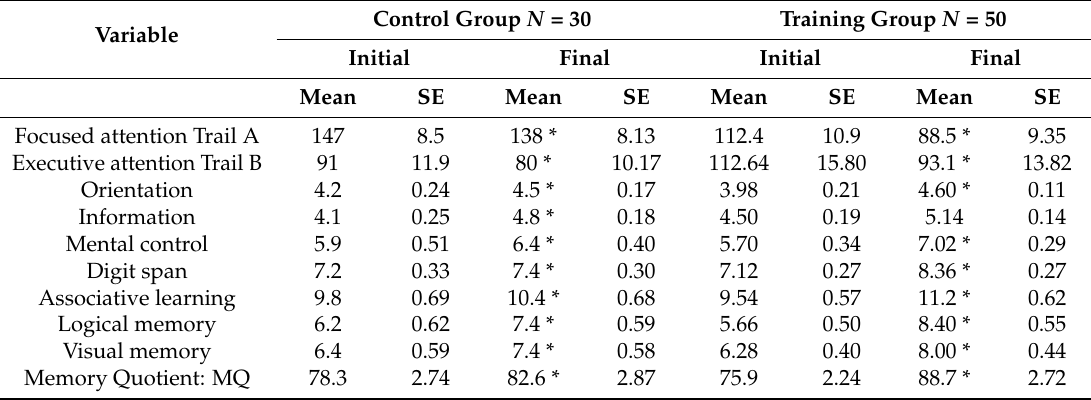
Memory Quotient: